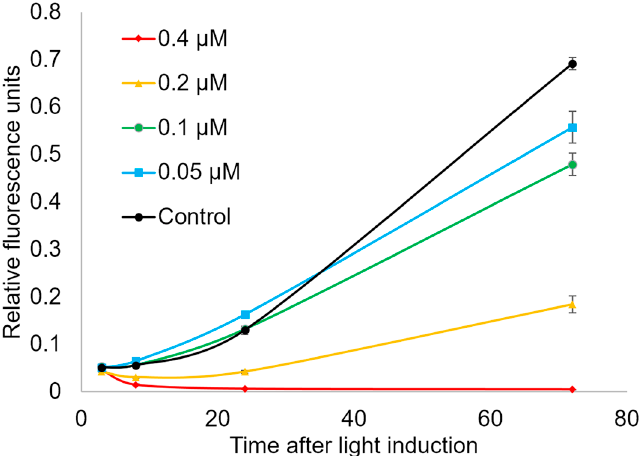
Figure 4. The growth dynamics of HeLa microcultures treated with Compound 21 with photoinduction (20 min, 660 nm). Relative fluorescence units indicate relative amount of fluorescein diacetate hydrolyzed by interaction with intact cell membranes for 40 min. This value is proportional to the number of cells in the well plate.